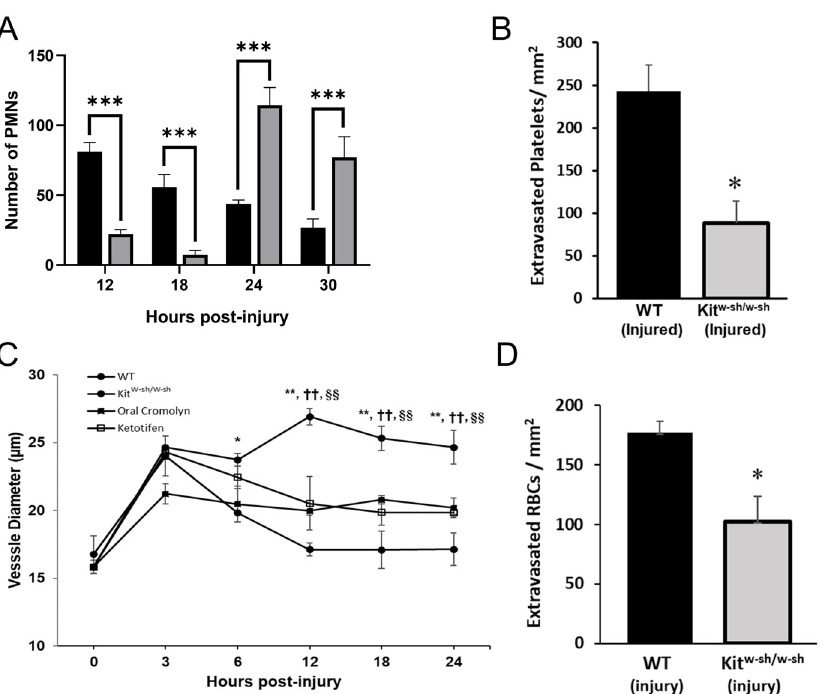
Figure 4. Inflammation after corneal abrasion in mast cell deficient (Kit W-sh/W-sh ) mice and WT mice treated with mast cell stabilizers. ( A ) Numbers of extravasated PMNs at the center of the cornea were determined at different times after epithelial abrasion (black bars = WT mice; grey bars = Kit W-sh/W-sh mice; n = 6 per group, *** p ≤ 0.001). ( B ) Numbers of extravasated platelets at the limbus 24 h post-injury were determined for WT and Kit W-sh/W-sh mice. ( n = 6 per group, ** p ≤ 0.01, *** p ≤ 0.001). ( C ) Venule diameters were determined at different times after corneal abrasion up to 24 h. ( n = 6 per group, * p ≤ 0.05 and ** p ≤ 0.01, compared to Kit w-sh/w-sh ; n = 6 per group, †† p ≤ 0.01 compared to oral cromolyn; n = 6 per group, §§ p ≤ 0.01 compared to ketotifen. ( D ) Numbers of extravasated RBCs at the limbus were determined at 18 h after corneal abrasion. ( n = 6 per group, * p ≤ 0.05).